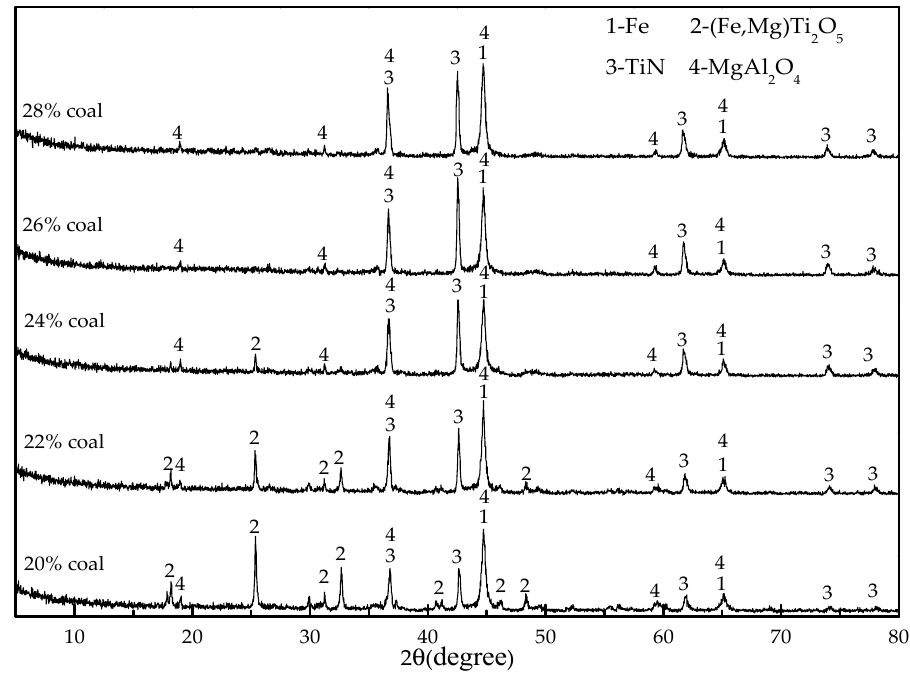
Figure 3. XRD patterns of pellets with different coal dosage reduced at 1300 °C after 90 min.